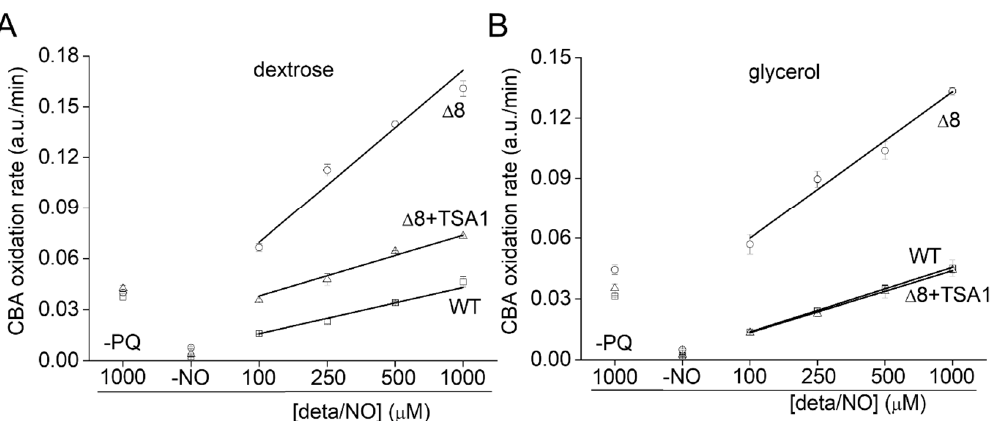
Figure 7. Rate of CBA oxidation in suspensions of Δ 8+TSA1 S. cerevisiae cells . ( A ) Rate of CBA oxidation by peroxynitrite fluxes in different S. cerevisiae strains. ( B ) Rate of CBA oxidation by peroxynitrite fluxes in different glycerol adapted S. cerevisiae strains. The labels -PQ and -NO respectively refer to a set of experiments excluding paraquat and the NO • donor as controls. The experimental conditions and fluorescence acquisition parameters are described in the Figure 1